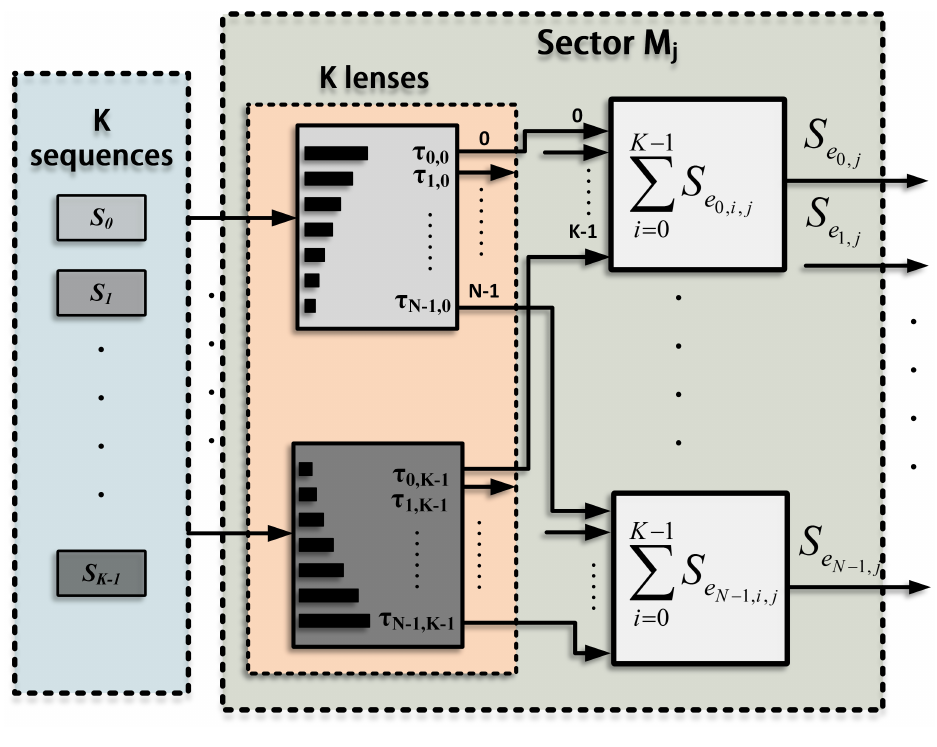
). The signals from i =0 , 1 ,...,K − 1